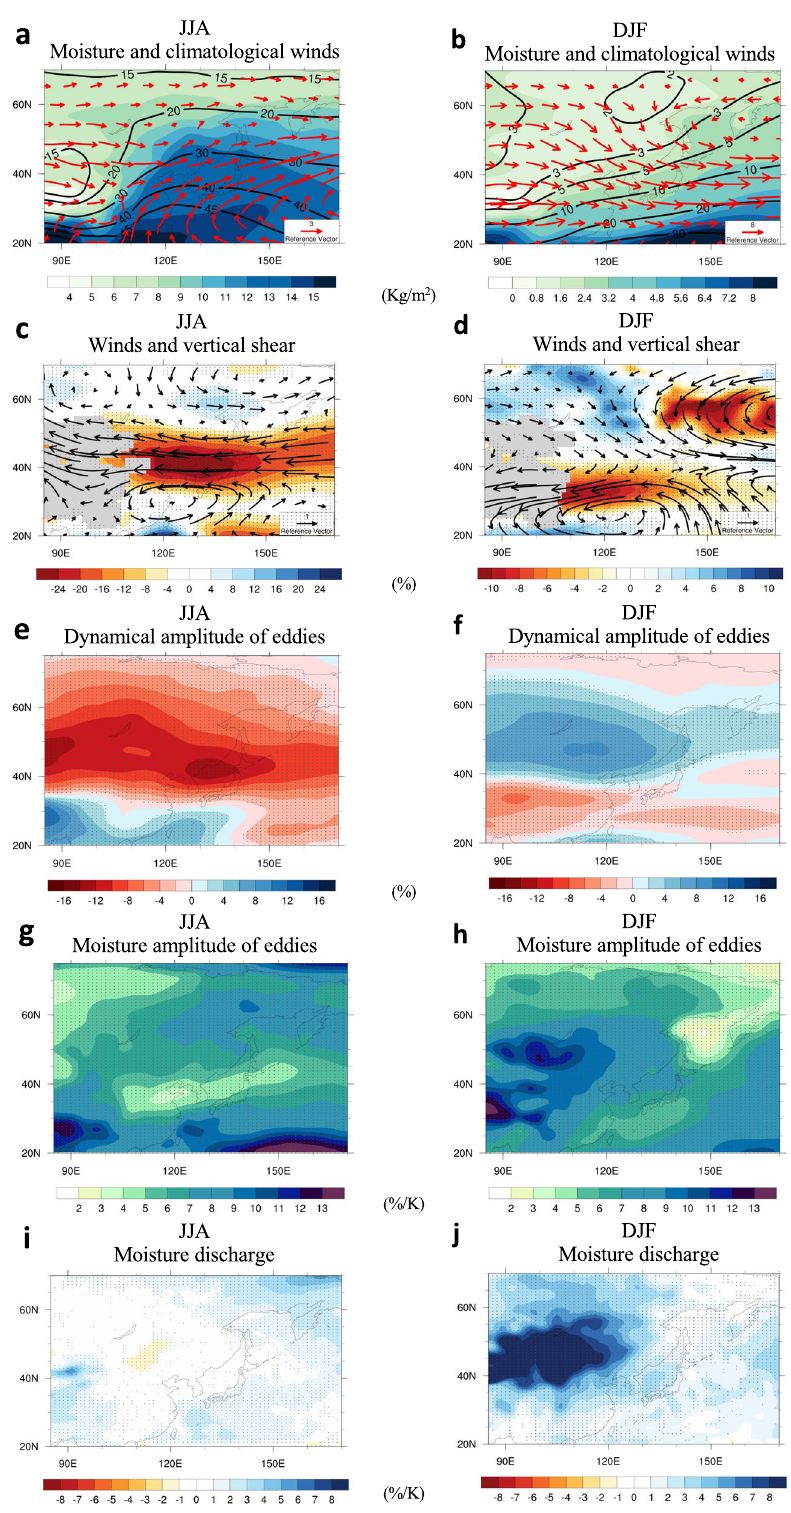
Fig. 3 Changes of physical processes in a warmer climate. a , b Changes of column water vapor content (color shading, unit in kg/m 2 ) overlayed on its climatology (contours) and the climatological vertically integrated winds weighted by speci fi c humidity (vector, unit in m/s) for JJA and DJF. The panels below are the same as ( a , b ) except for different fi elds. c , d Changes of tropospheric winds at 300 hPa (vector) and percentage changes of the magnitude of the vertical wind shear (color shading, unit in %, blue color represents larger value to denote the relationship with precipitation). e , f Percentage changes of the dynamical amplitude of eddies in the upper troposphere at 300 hPa (unit in %, blue color represents larger value). g , h Percentage changes in the eddy amplitude of precipitable water (unit in %/K). i , j Percentage changes scaled by unit temperature change in the discharge rate of precipitable water during the extreme precipitation events at 99% threshold (unit in %/K) (see Methods in SI). Stippling represents statistical signi fi cance at 5% level in student t